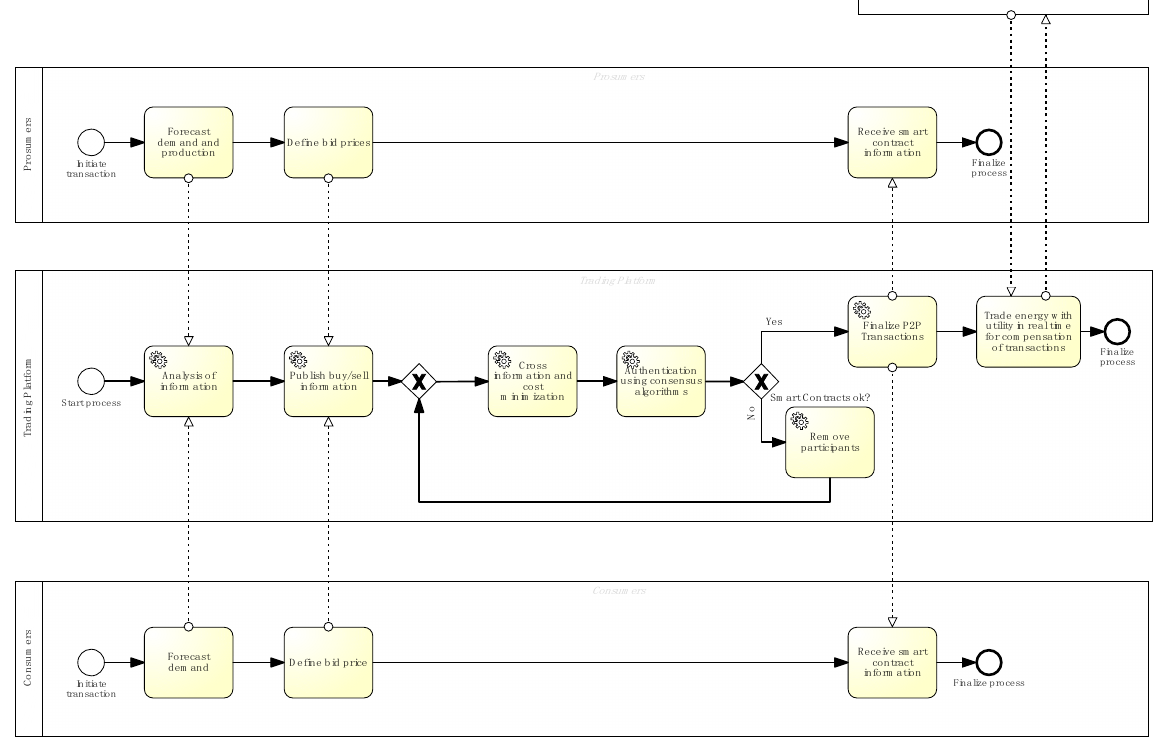
Figure 10. Proposed market operation diagram.